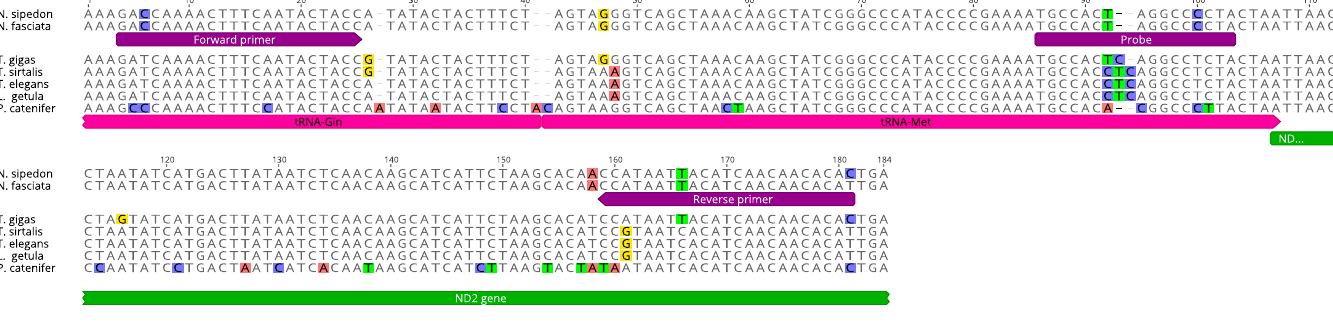
Fig 3. Sequence alignment of Nerodia and non-target species with qPCR primer and probe locations.